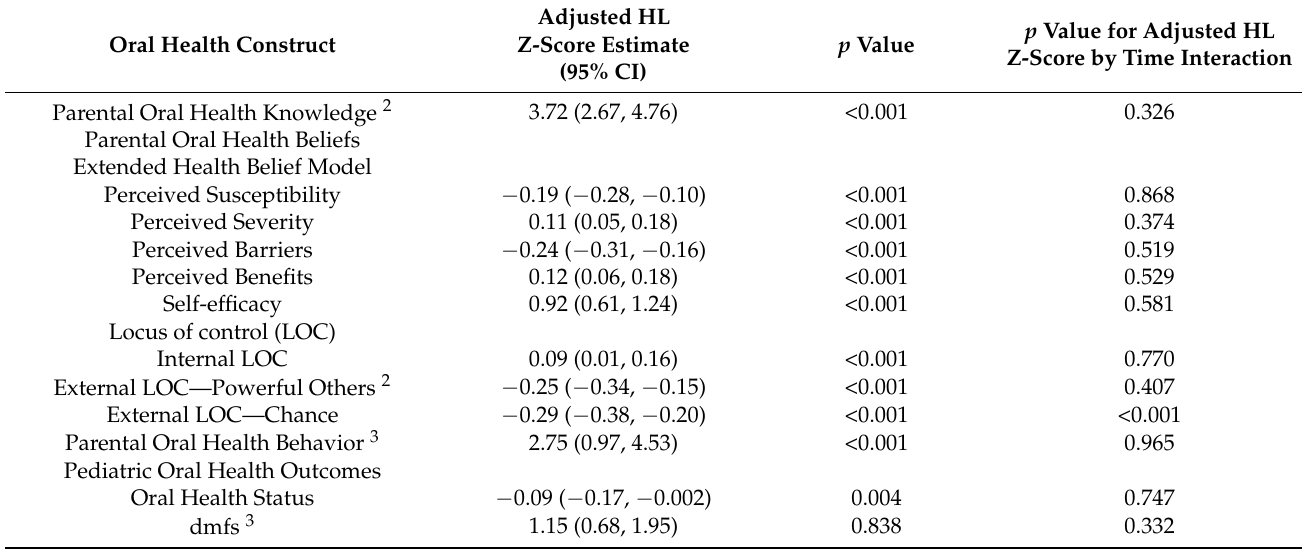
Table 2. Baseline Health Literacy (HL) as a Predictor of Change over Time in the Oral Health Constructs 1 .